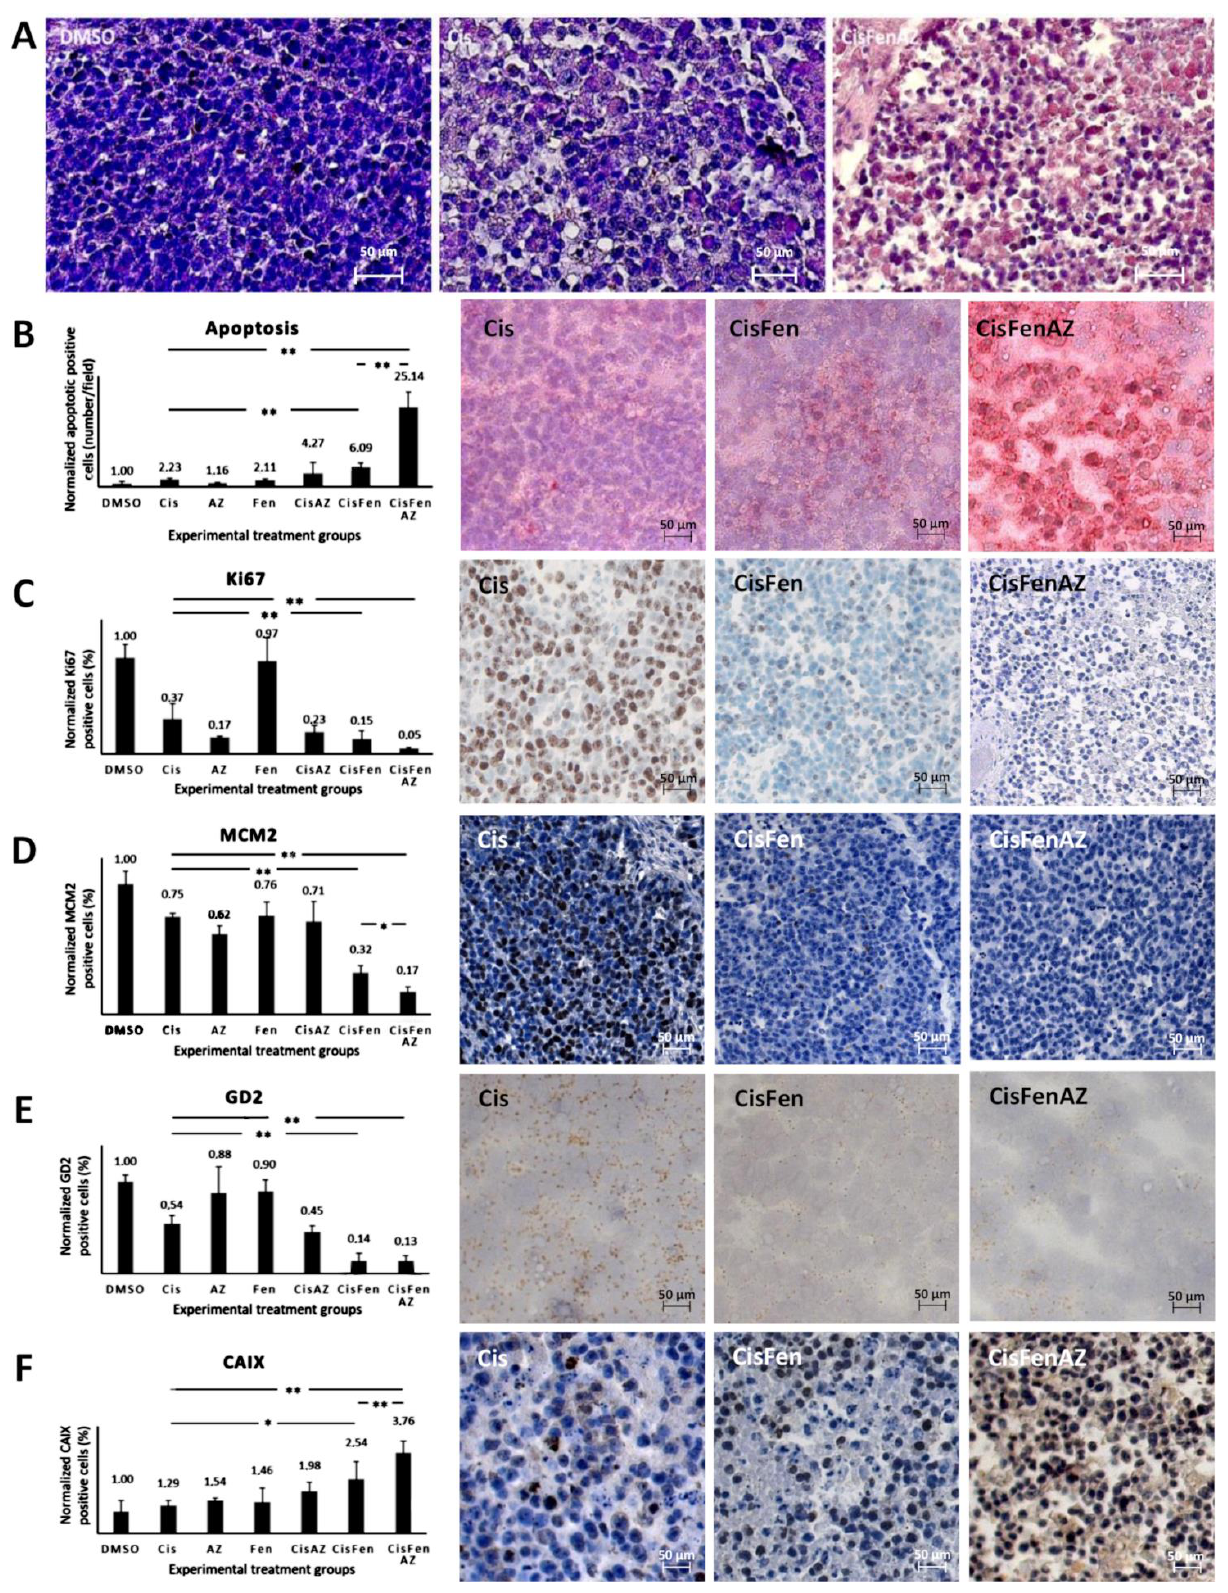
Figure 2. Hystochemical analysis of SKNBE2 nodules. Representative images of hematoxylin staining of SKNBE2 nodules ( A ) from vehicle- (DMSO), cisplatin- (Cis) and cisplatin, fendiline, and acetazolamide- (CisFenAZ) treated mice. The per- centage of pycnotic nuclei and mass disaggregation is strongly increased by CisFenAZ treatment. Quantification of apop- totic cells by TUNEL assay in SKNBE2 nodules after treatments ( B ). Values refer to the amount of TUNEL-positive cells per field (left plot). Panels on the right show representative images of cisplatin- (Cis), cisplatin/fendiline- (CisFen) and